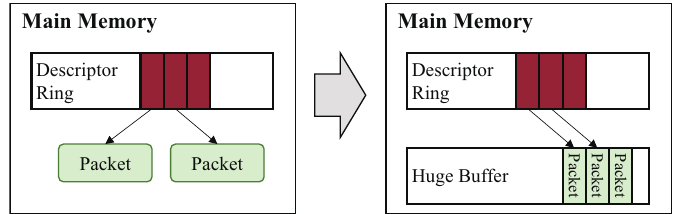
Figure 4. The huge reusable buffer allocates a memory pool for incoming packets at the initialization of